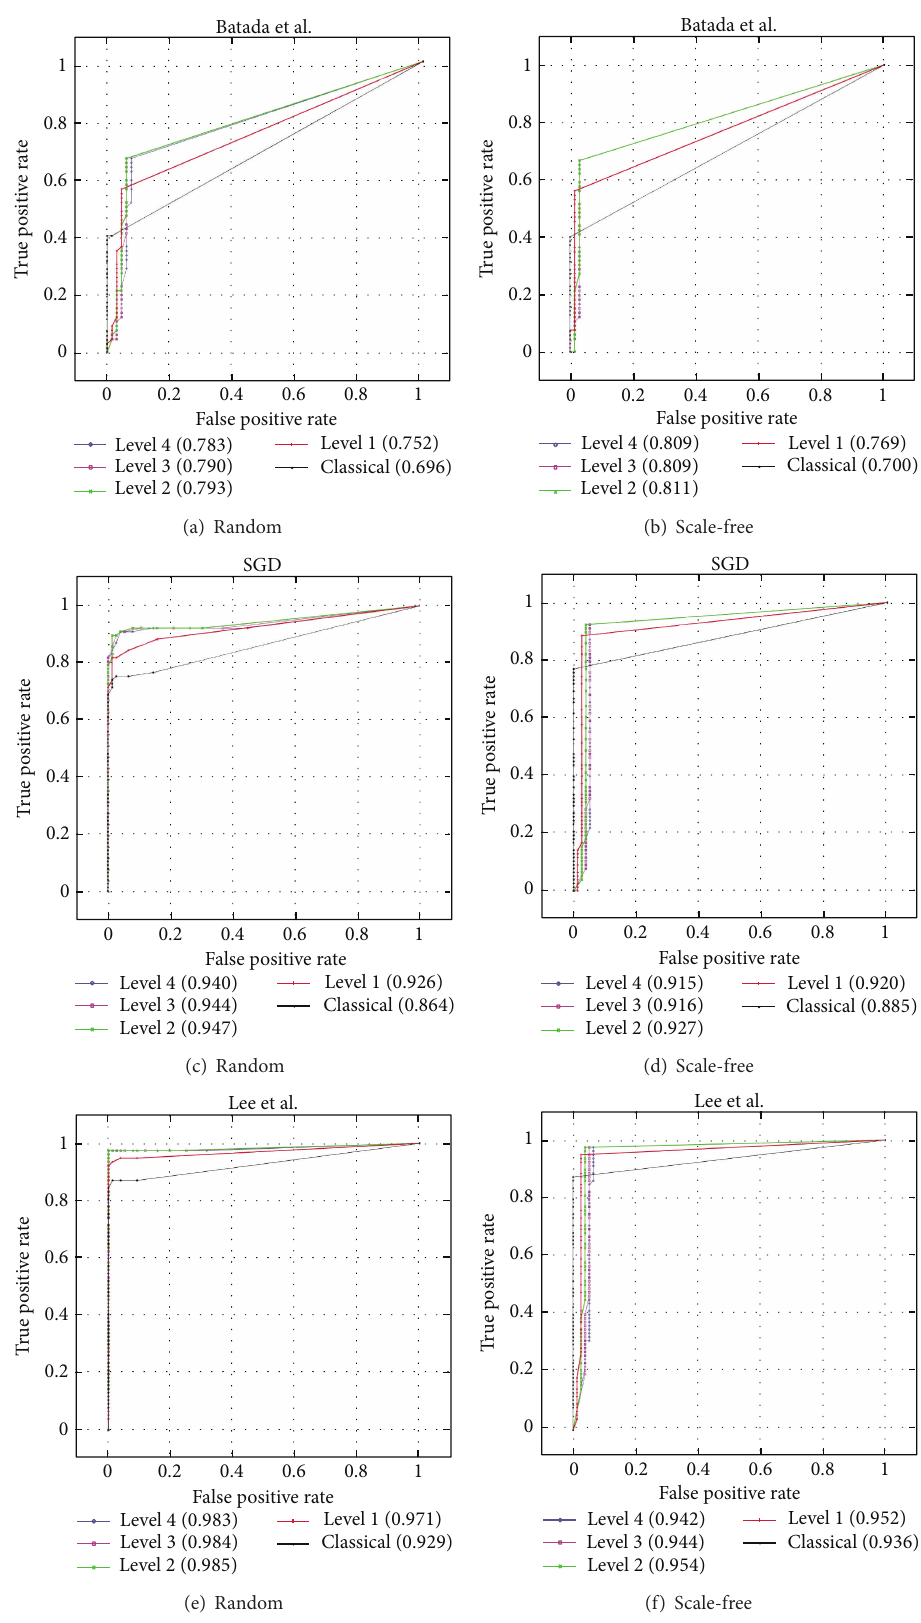
Figure 6: ROC analysis of our methodology using some yeast networks. For this analysis two different topologies were used: pure random and scale-free